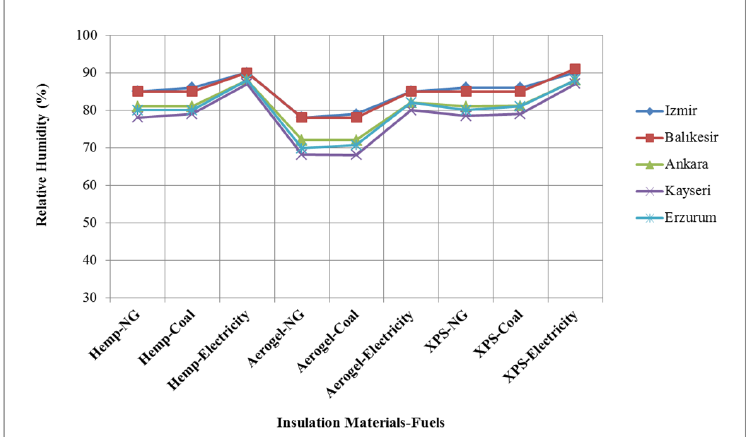
Figure 11. Relative humidity values required for mold that may occur indoors at optimum insulation thickness due to different energy sources and insulation materials.